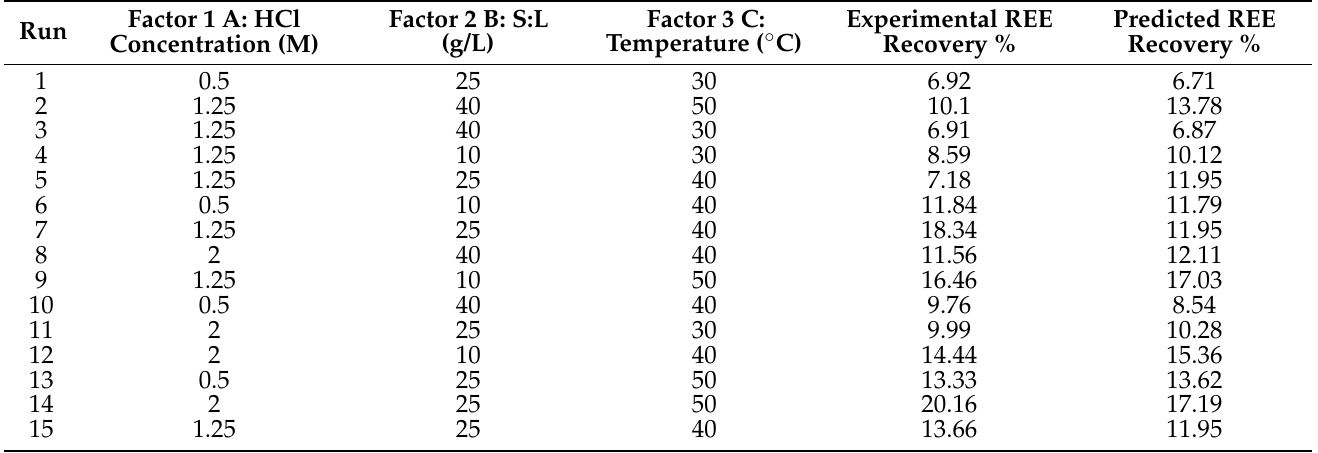
Table 3. Experimental vs. predicted % REE leaching recovery from RC1.